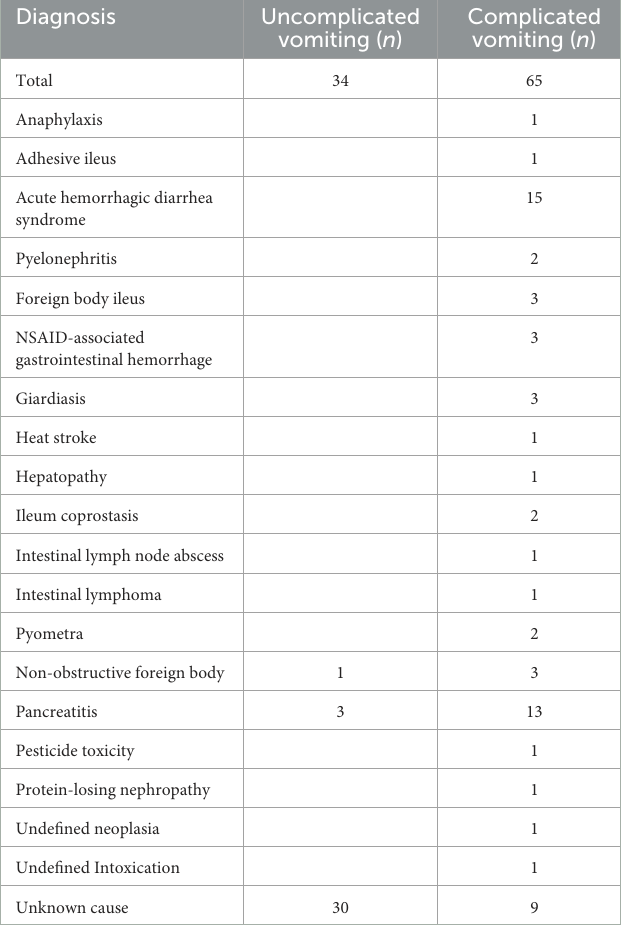
TABLE 1 Diagnosis of 34/99 dogs with uncomplicated vomiting and 65/99 dogs with complicated vomiting. Diagnosis Uncomplicated Complicated vomiting ( n ) vomiting ( n